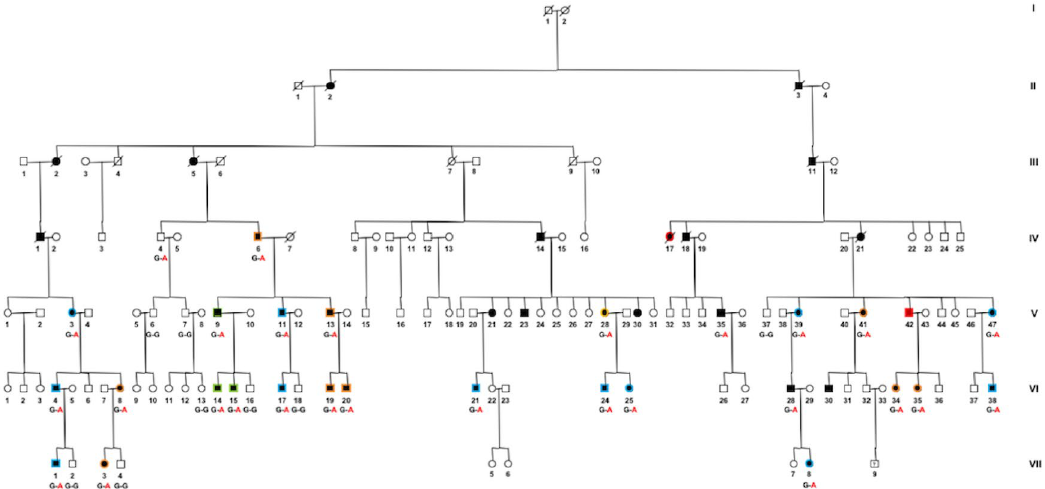
Figure 1. Pedigree of the large dominant optic atrophy family with the SSBP1 c.113G > A variant. Isolated DOA = black symbols surrounded by an orange border. DOA plus foveopathy = black symbols surrounded by a blue border. DOA plus rod cone dystrophy = black symbols surrounded by a red border. Asymptomatic carriers = black symbols surrounded by a green border. Individual V:41 had a type 2 diabetes diagnosed at the age of 62, all other affected patients had no systemic disorder. This pedigree was drawn by B.B. using Cyrillic software version 2.1.3 (https:// www. apben son. com/ softw